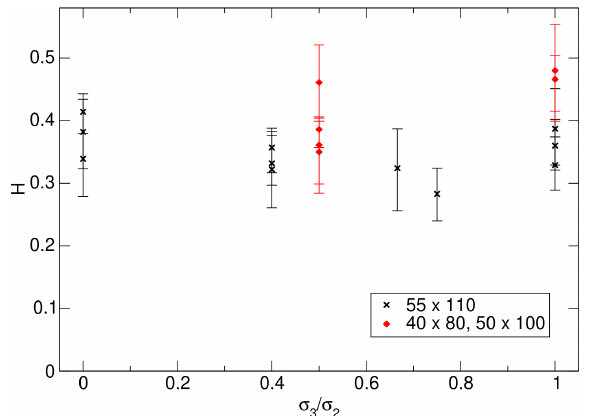
Figure 12. Average and variability of Hurst exponents for surfaces generated with different ratio of confining stresses σ 2 and σ 3 . Black: this work, red: data from Ohagen (2019). Error bars show top and bottom